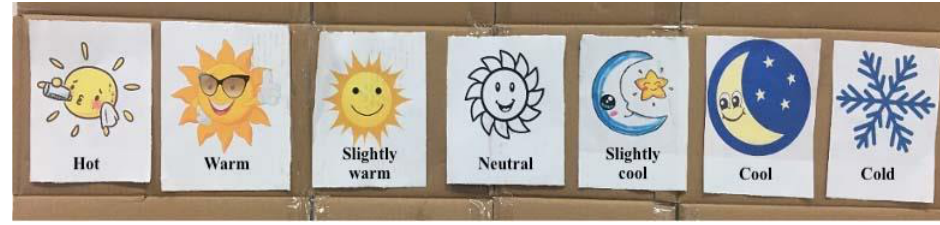
Figure 3. Expression form of thermal sensation questionnaire for preschool children.